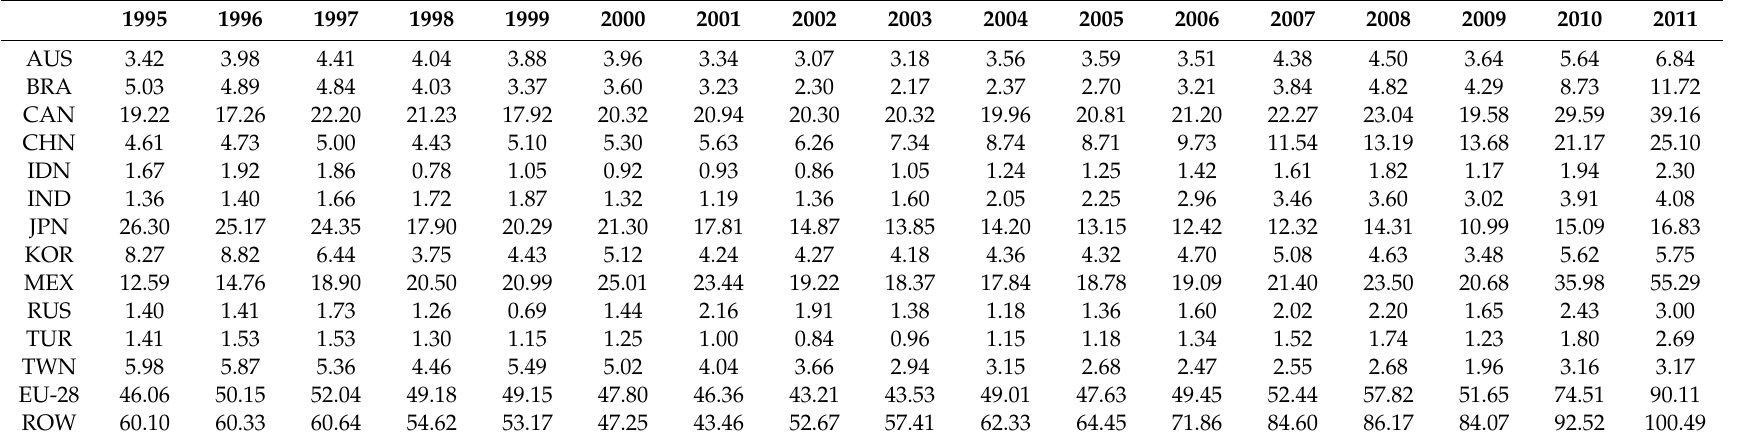
Table A4. US’s virtual oil exports (mtoe).